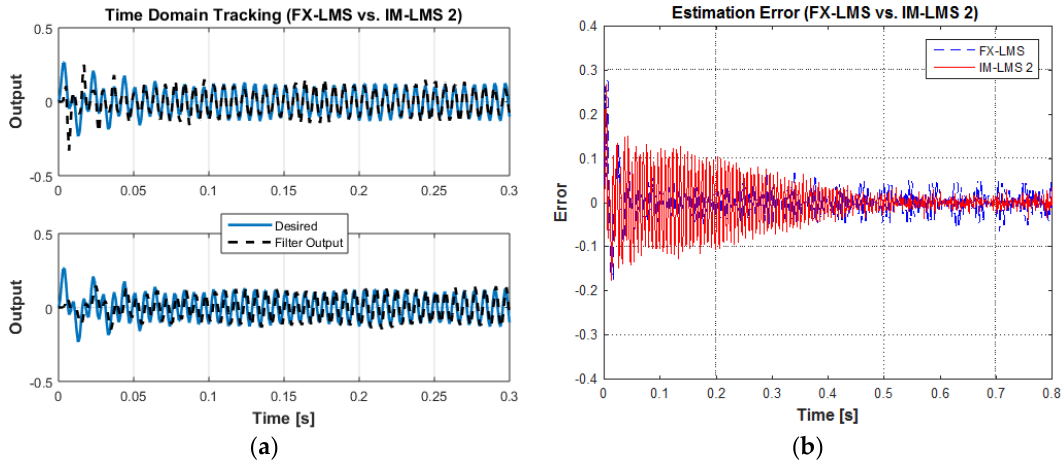
Figure 10. Control of a frequency-modulated (FM) signal. ( a ) Time-domain tracking with LMS and internal model LMS 2 methods; ( b ) estimation error.